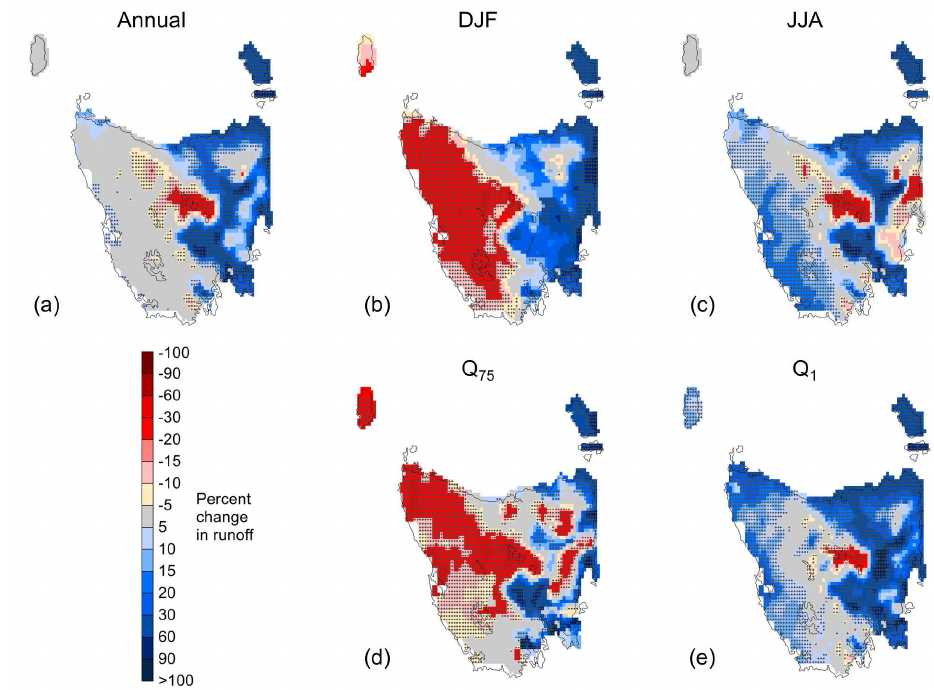
Fig. 12. Change in runoff simulated by SIMHYD from 1961–1990 to 2070–2099. (a) Change in mean annual runoff. (b) Change in mean DJF runoff. (c) Change in mean JJA runoff. (d) Change in Q 75 runoff. (e) Change in Q 1 runoff. Changes are calculated from the mean of the six RCM simulations. Stippling shows regions where at least five of the six RCM simulations agree on the sign of